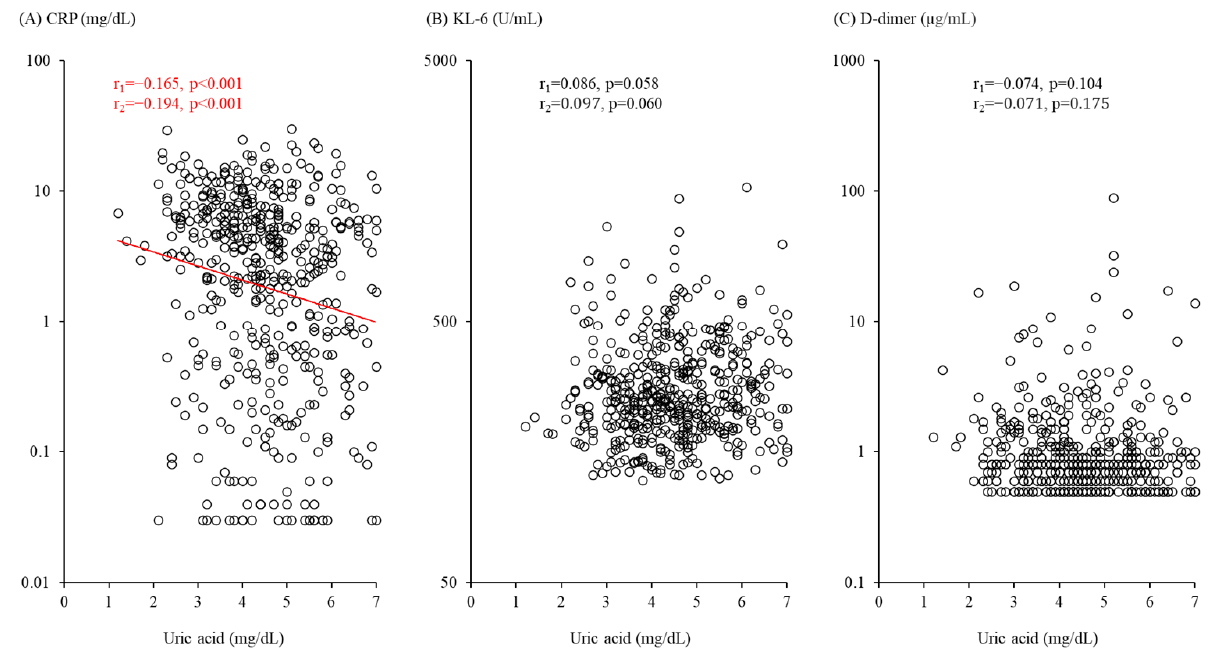
Figure 1. Associations of serum uric acid with level of ( A ) serum C-reactive protein (CRP), ( B ) serum Krebs von den Lungen-6 (KL-6), and ( C ) plasma D-dimer. r 1 = Pearson’s correlation coefficient (standardized coefficient) from simple linear regression. r 2 = Standardized coefficient from multiple linear regression, with the following variables included: age, sex, body mass index, smoking habit, presence of diabetes mellitus, hypertension, dyslipidemia, cerebrovascular and/or cardiovascular disease, chronic respiratory disease, estimated glomerular filtration rate, days from onset of illness to hospital admission, coronavirus disease 2019 severity at admission, and use of uric acid-lowering agents.